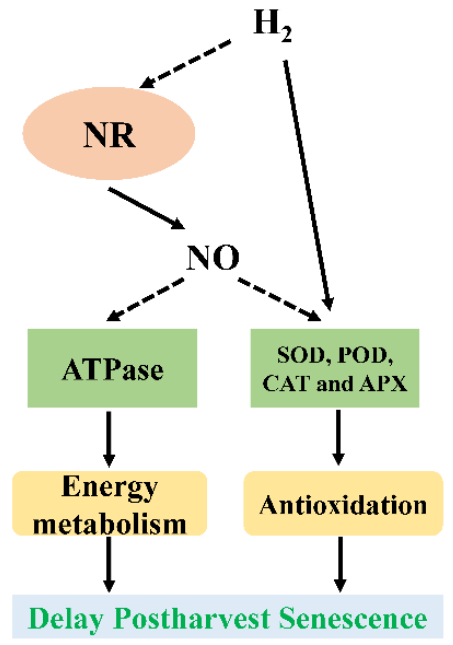
Figure 3. Schematic model depicting the requirement of NO in H 2 -delayed senescence of cut flowers. APX, ascorbate peroxidase; CAT, catalase; H 2 , hydrogen gas; NO, nitric oxide; NR, nitrate reductase; POD, peroxidase; SOD, superoxide dismutase.